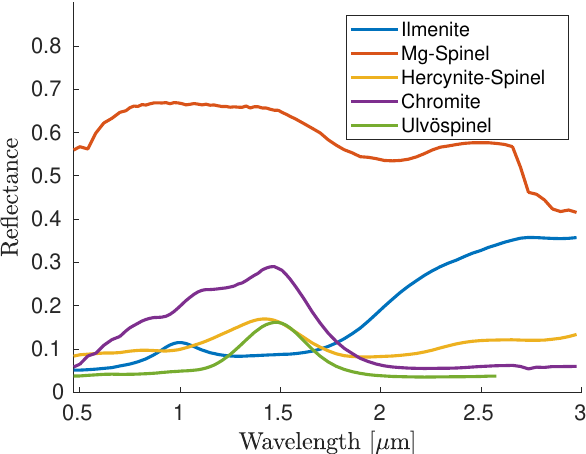
Figure 7. Blue curve: mineral separate of ilmenite sample (spectral ID: LR-CMP-222). Red curve: Mg-spinel (MgAl O 4 ) with low iron content (spectral ID: SP-EAC-021). Yellow curve: hercynite 2 (FeAl 2 O 4 ) (spectral ID: SP-EAC-074). Violet curve: chromite (FeCr 2 O 4 ) (spectral ID: CR-EAC-017). The spinel spectra are from terrestrial analogue materials. They were taken from Cloutis et al. [60] and downloaded from the RELAB spectral library. Green curve: ulvöspinel (FeFeTiO 4 ) (RELAB database, spectral ID: MR-MSR-004, synthetically created